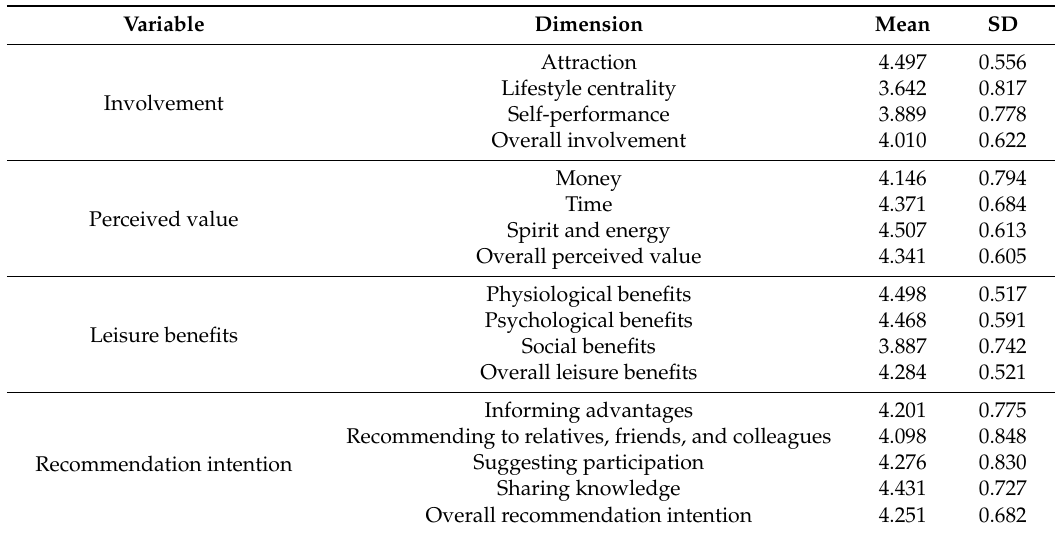
Table 2. Analysis of research variable